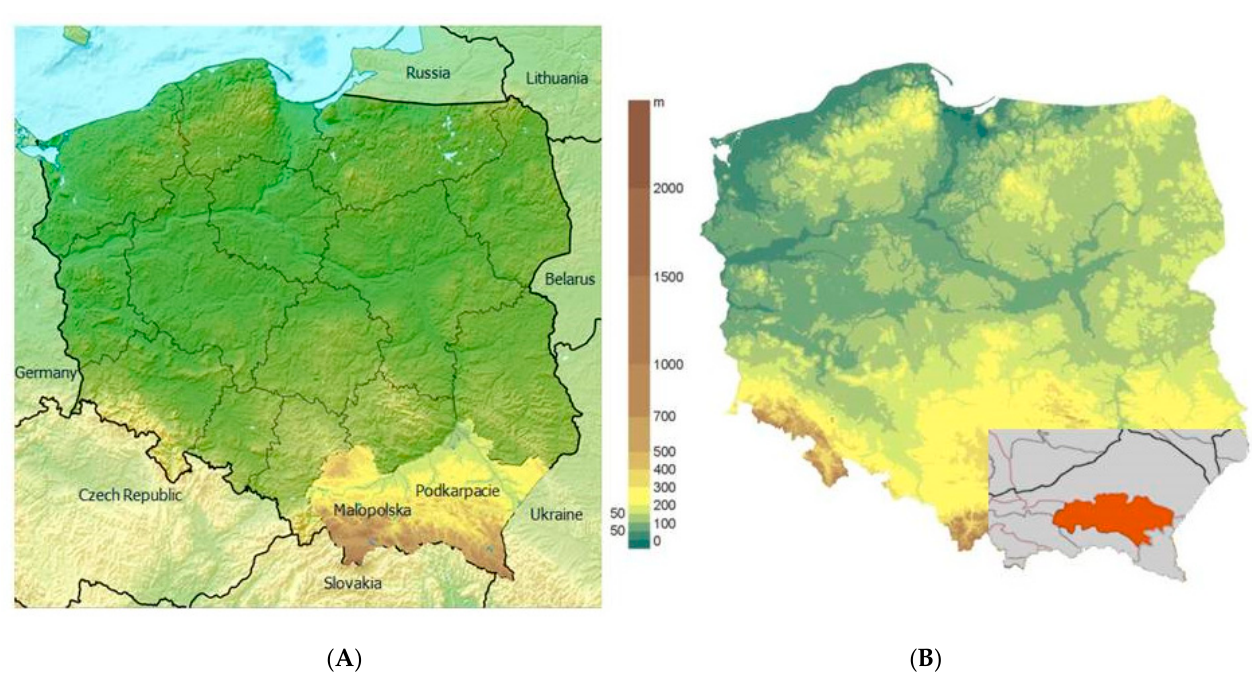
Figure 4. Map of Poland with Malopolska and Podkarpacie provinces ( A ) and with the regions where honey samples were